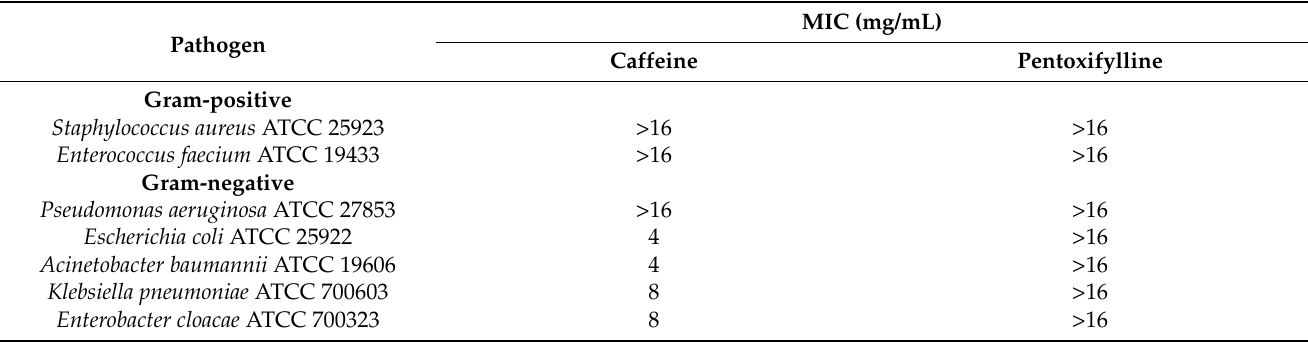
Table 3. Antibacterial activity of xanthines: caffeine and pentoxifylline against selected Gram-positive and Gram- negative pathogens.